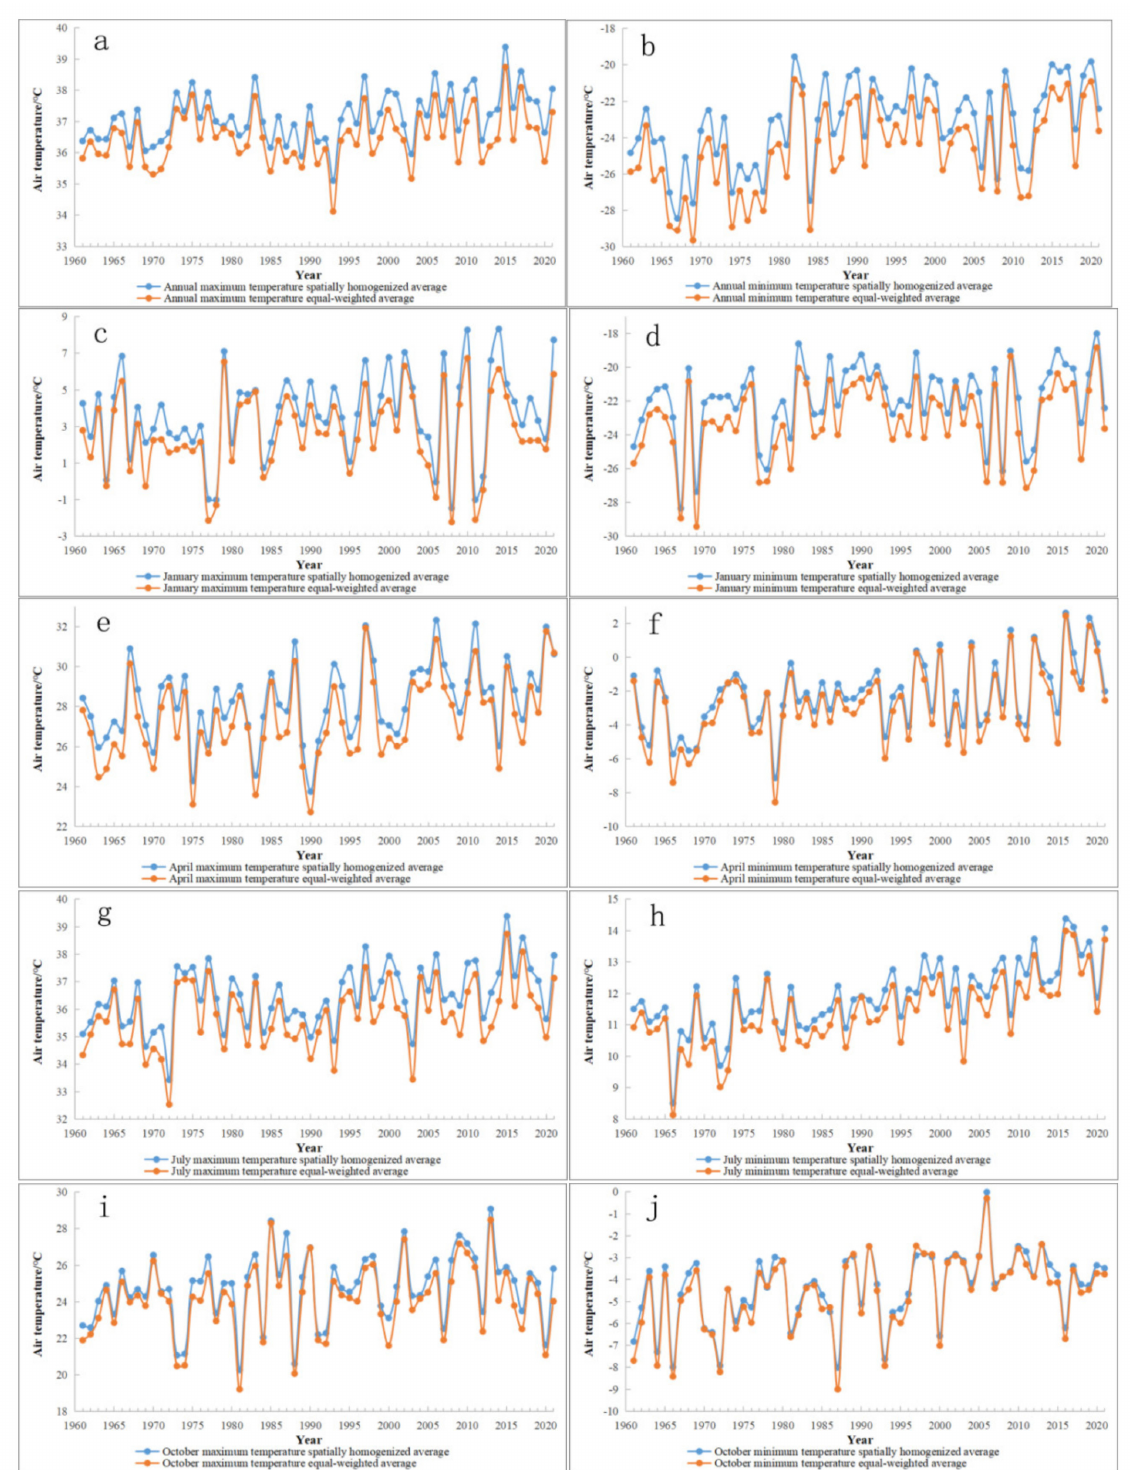
Figure 7. The maximum and minimum temperatures of the spatial homogenization revised average and equal-weighted average in Xinjiang, 1961 − 2021 ( a ): Annual maximum temperature; ( b ): Annual minimum temperature; ( c ): January maximum temperature; ( d ): January minimum temperature; ( e ): April maximum temperature; ( f ): April minimum temperature; ( g ): July maximum temperature; ( h ): July minimum temperature; ( i ): October maximum temperature; ( j ): October minimum